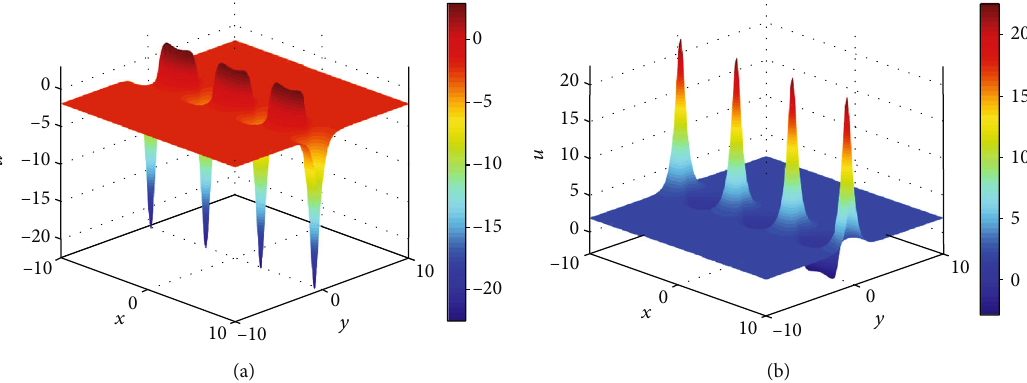
= 1 , b = − 1 , k = 1 , p = 2 , and ϕ = 0 at t = 0 . (a) Bright-type 0 0